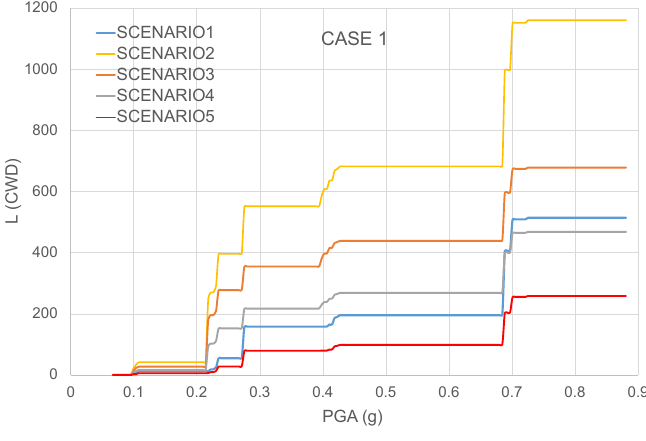
Figure 6. Case 1 ( n 1 = 3, n 2 = 6).